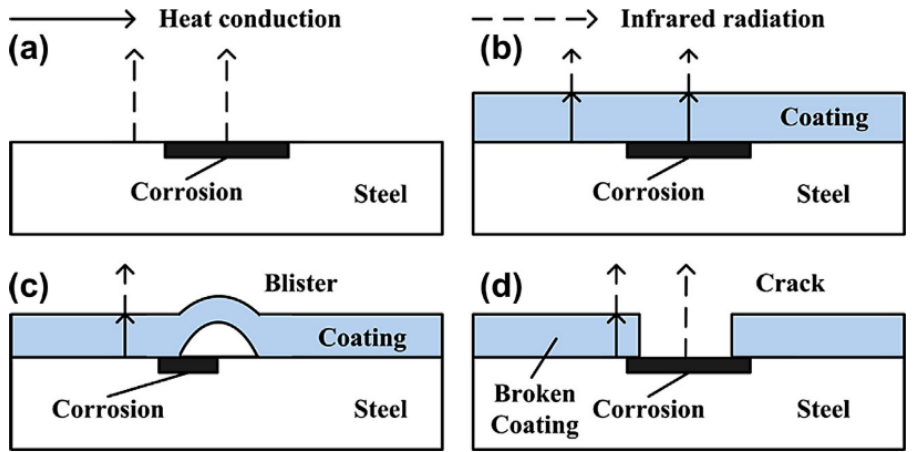
Figure 11. The effect on the measured thermal energy of different coating failure modes: ( a ) corrosion, ( b ) under coating corrosion, ( c ) blistering, ( d ) coating failure. (Reprinted with permission from ref. [56]. Copyright 2014 Elsevier).